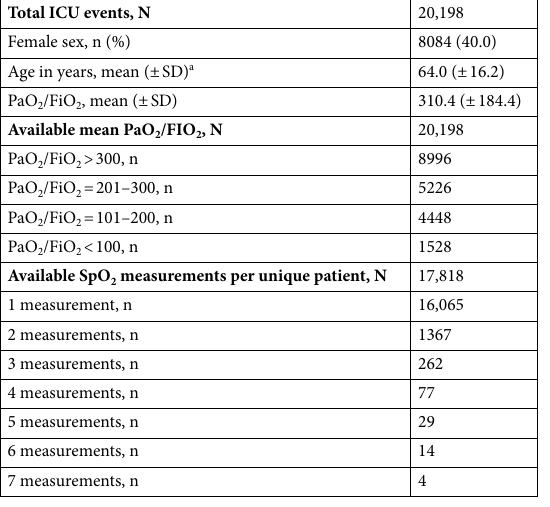
Table 2. Subject characteristics based on three features. The 3-feature models captured 20,198 ICU events from 17,818 unique patients. Variables included in the 3-feature machine learning models are SpO 2 , FiO 2 , and